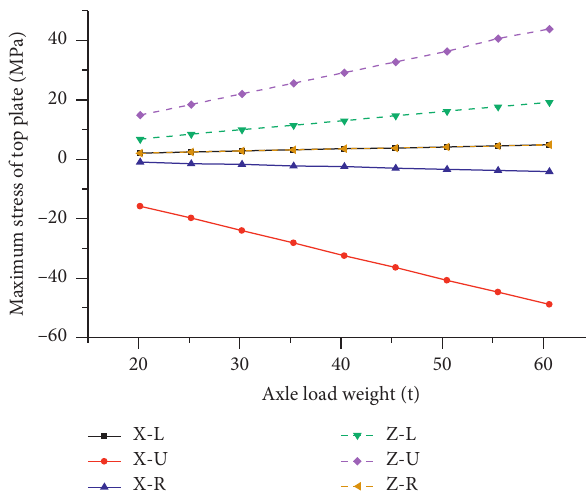
Figure 20: Influence of the change of axle load on the maximum stress of the top